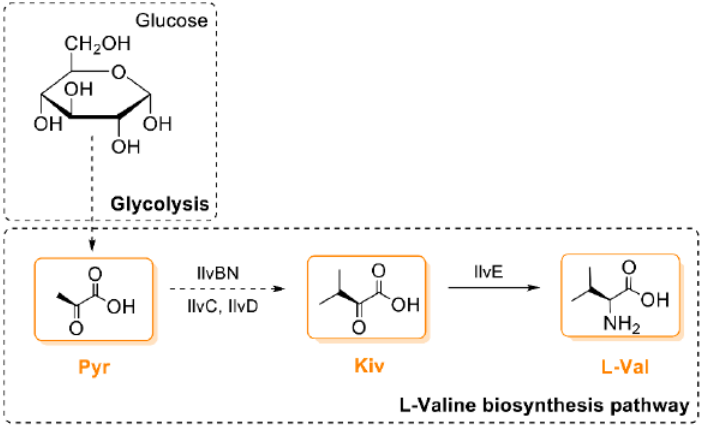
Figure 4. The biosynthetic pathway of valinomycin precursors in E. coli . IlvBN, acetohydroxy acid synthase I; IlvC, acetohydroxy acid isomeroreductase; IlvD, dihydroxy acid dehydratase; IlvE, branched chain amino acid aminotransferase; Pyr, pyruvate; Kiv, ketoisovalerate; L -Val, L